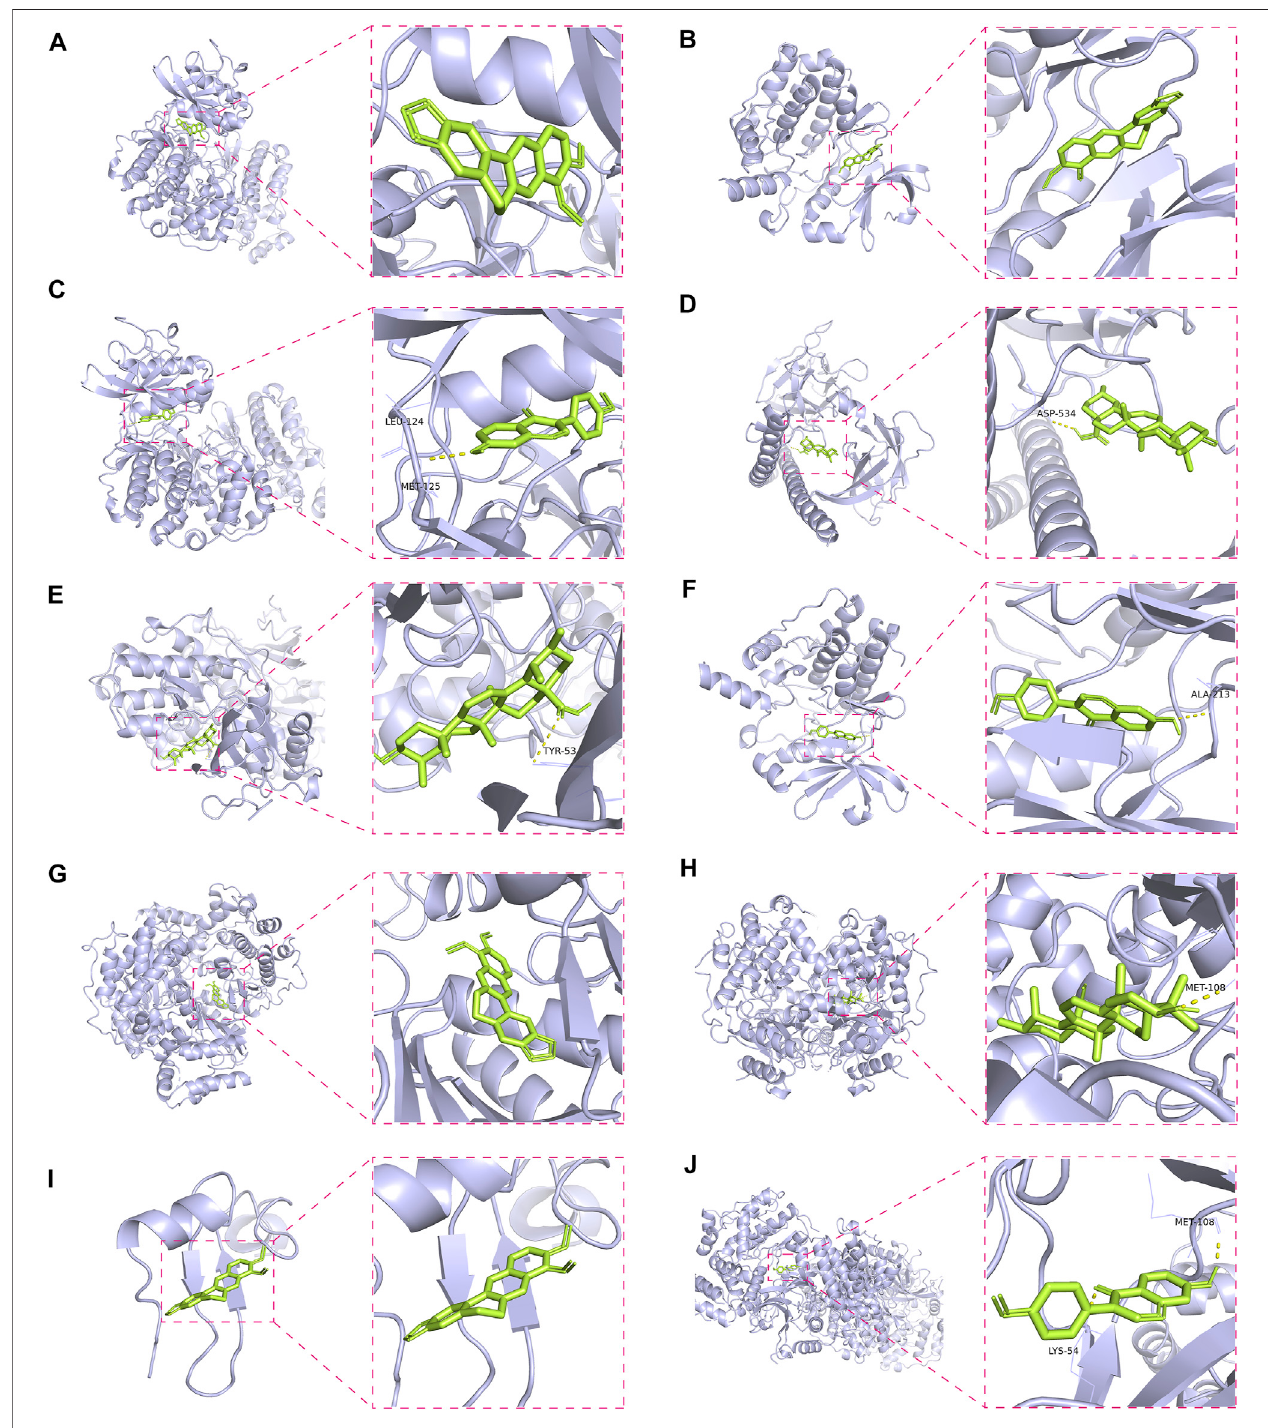
FIGURE 5 | Molecular docking of the hub targets with bioactive compounds. (A) Binding poses of berberine complexed with MAPK, af fi nity = − 9.2 kcal/mol; (B) Binding poses of berberine complexed with MYC, af fi nity = − 8.8 kcal/mol; (C) Binding poses of formononetin complexed with MAPK3, af fi nity = − 8.7 kcal/mol; (D) BindingposesofursolicacidcomplexedwithJUN,af fi nity= − 8.1 kcal/mol; (E) BindingposesofursolicacidcomplexedwithMAPK3,af fi nity= − 8.1 kcal/mol; (F) Binding poses of formononetin complexed with MYC, af fi nity = -8 kcal/mol; (G) Binding poses of berberine complexed with MAPK1, af fi nity = − 7.8 kcal/mol; (H) Binding poses of ursolic acid complexed with MAPK1, af fi nity = − 7.7 kcal/mol; (I) Binding poses of berberine complexed with EGF, af fi nity = − 7.4 kcal/mol; (J) Binding poses of formononetin complexed with MAPK1, af fi nity = − 7.3 kcal/mol.